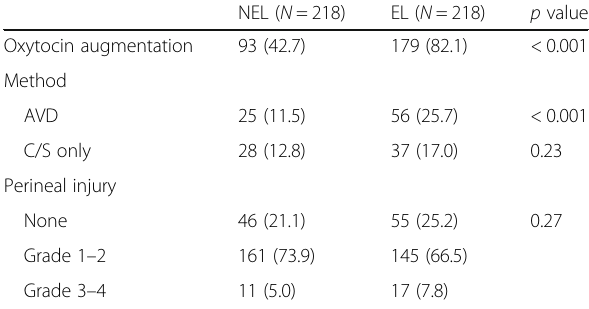
Table 2 Method of delivery and incidence of perineal